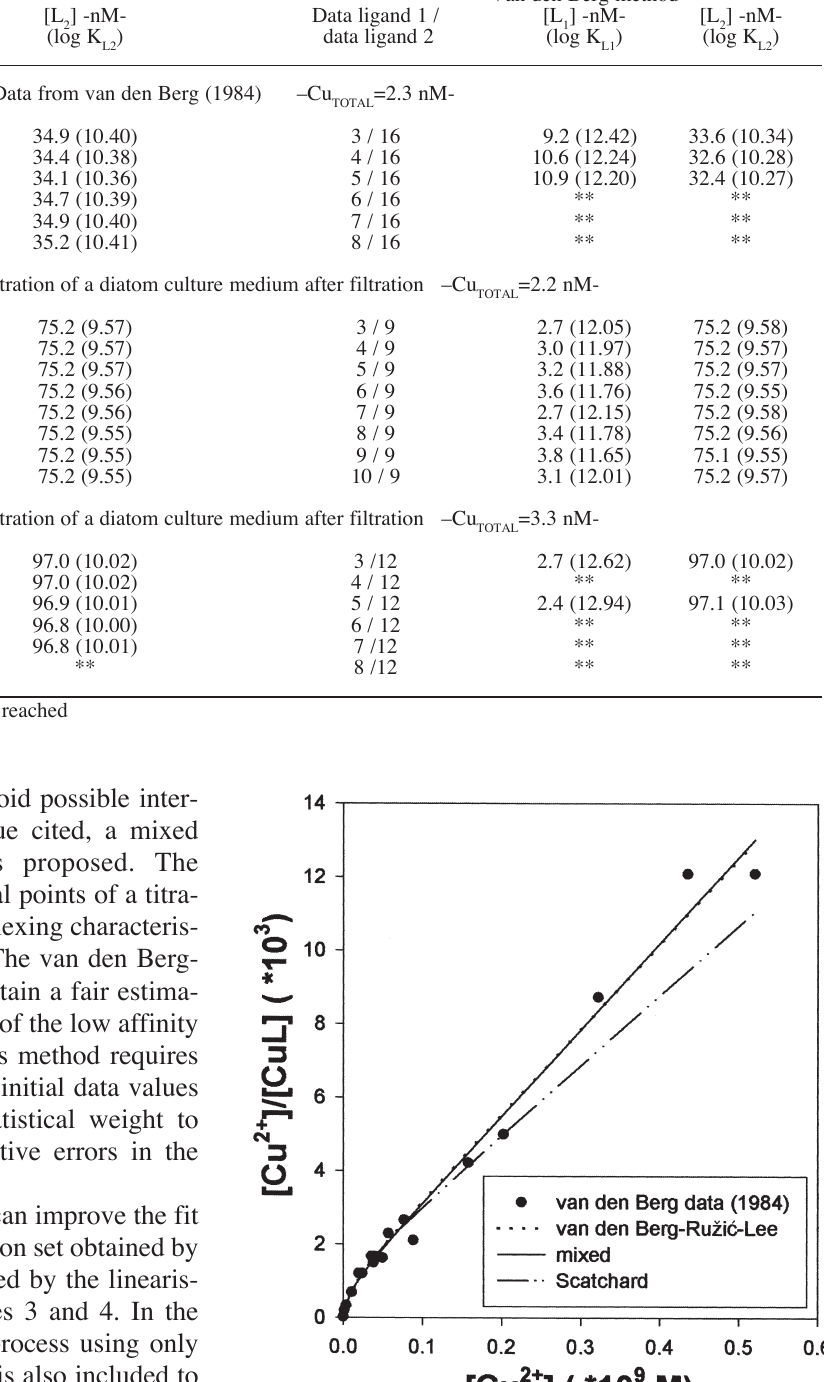
T ABLE 1. – Complexing parameter values for three differents copper data titrations of seawater samples from open ocean and from culture mediums of P. tricornutum . A two-binding site model was adopted. Two iterative methods were used: the method proposed by Van den Berg (1984) and the mixed method suggested in the present work. Different values come from changes in the number of data used to obtain the complexing characteristics of the high stability ligands. Mixed method